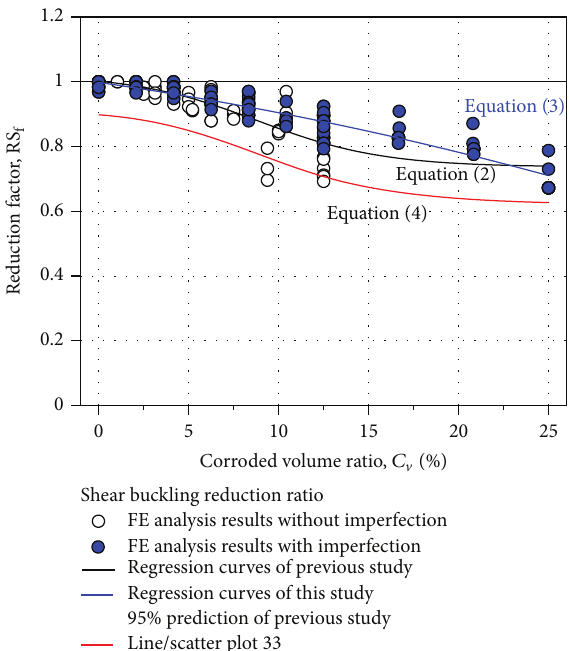
Figure 9: Shear buckling reduction factor equation.